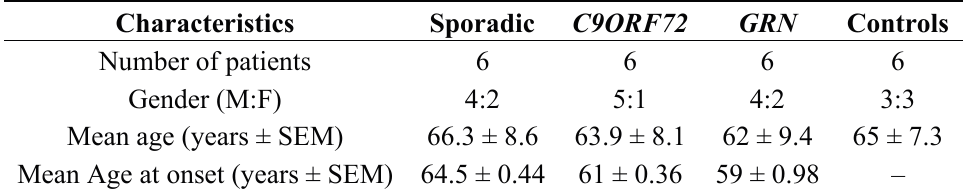
Table 1. Characteristics of frontotemporal dementia (FTD) patients and